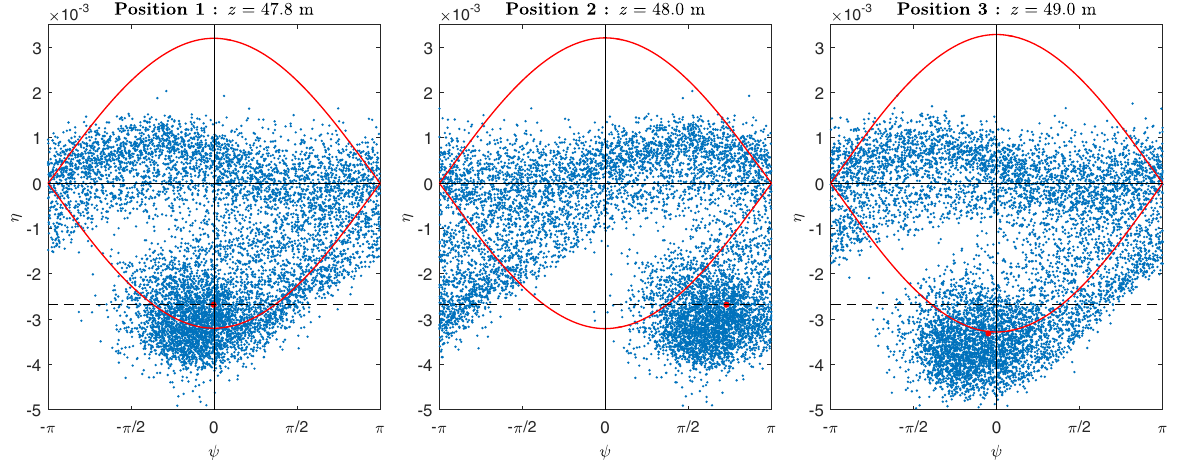
FIG. 6. Result of steady-state simulation. Snapshots in the longitudinal phase space ð ψ ; η Þ showing a microbunch deceleration cycle in the in-bucket regime. The red dot represents the average particle within the microbunch.